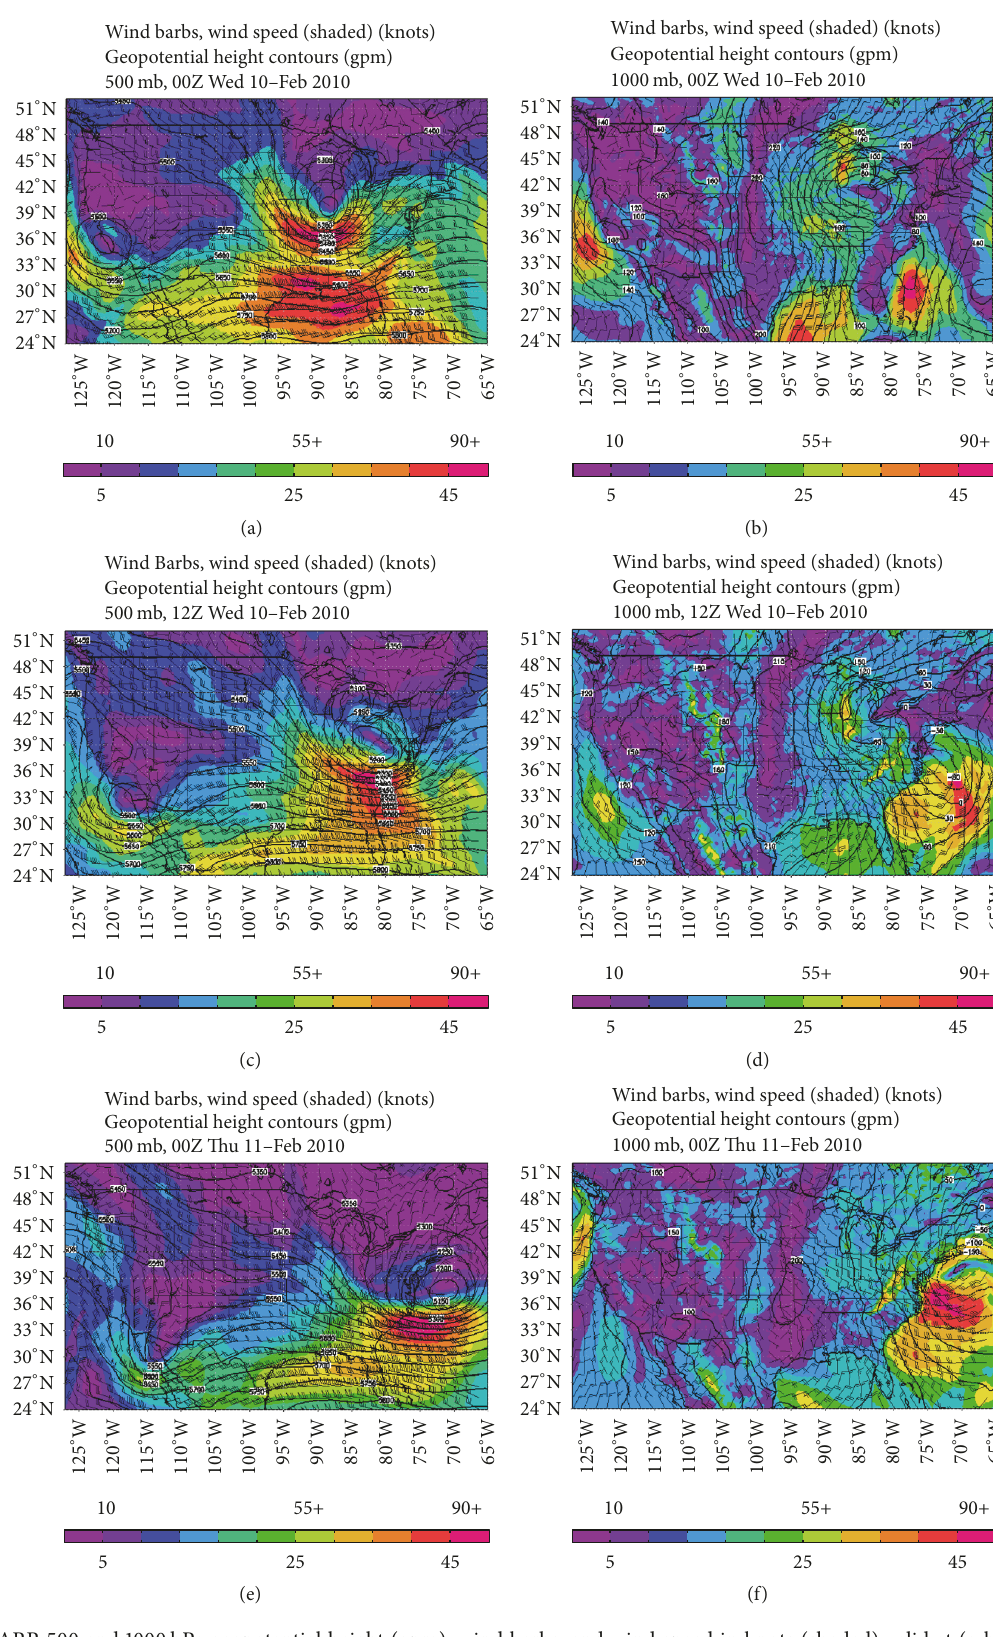
Figure 6: NARR 500 and 1000hPa geopotential height (gpm), wind barbs, and wind speed in knots (shaded) valid at (a-b) 0000 UTC 10 February, (c-d) 1200 UTC 10 February 2010, and (e-f) 0000 UTC 11 February